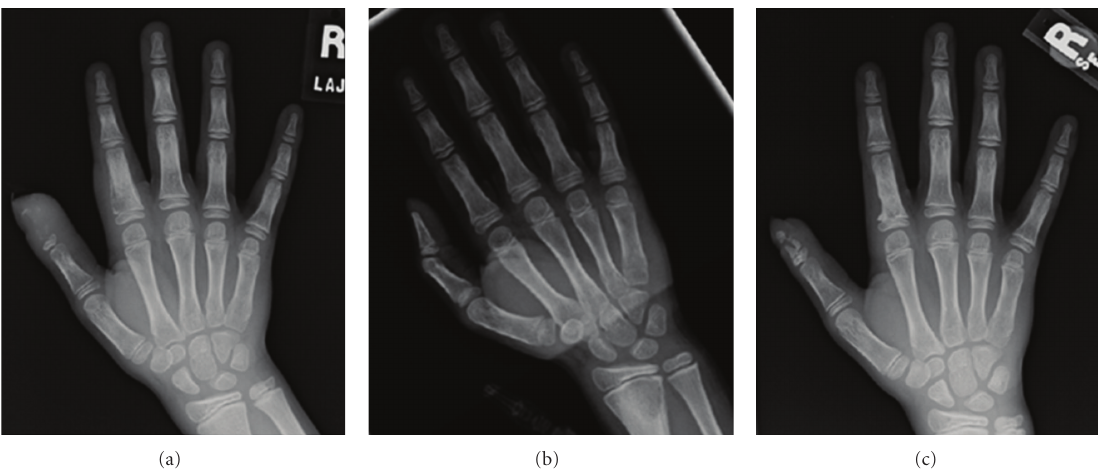
Figure 1: (a) Plain film of the right hand showing almost complete demineralization of the distal phalanx of the thumb and periosteal elevation and osteolysis of the proximal phalanx of the second digit. (b) Plain film obtained during skeletal survey after readmission, demonstrating an osteolytic lesion of the distal left radius. (c) Plain film of the right hand obtained after four months of antifungal therapy, demonstrating remineralization of the distal